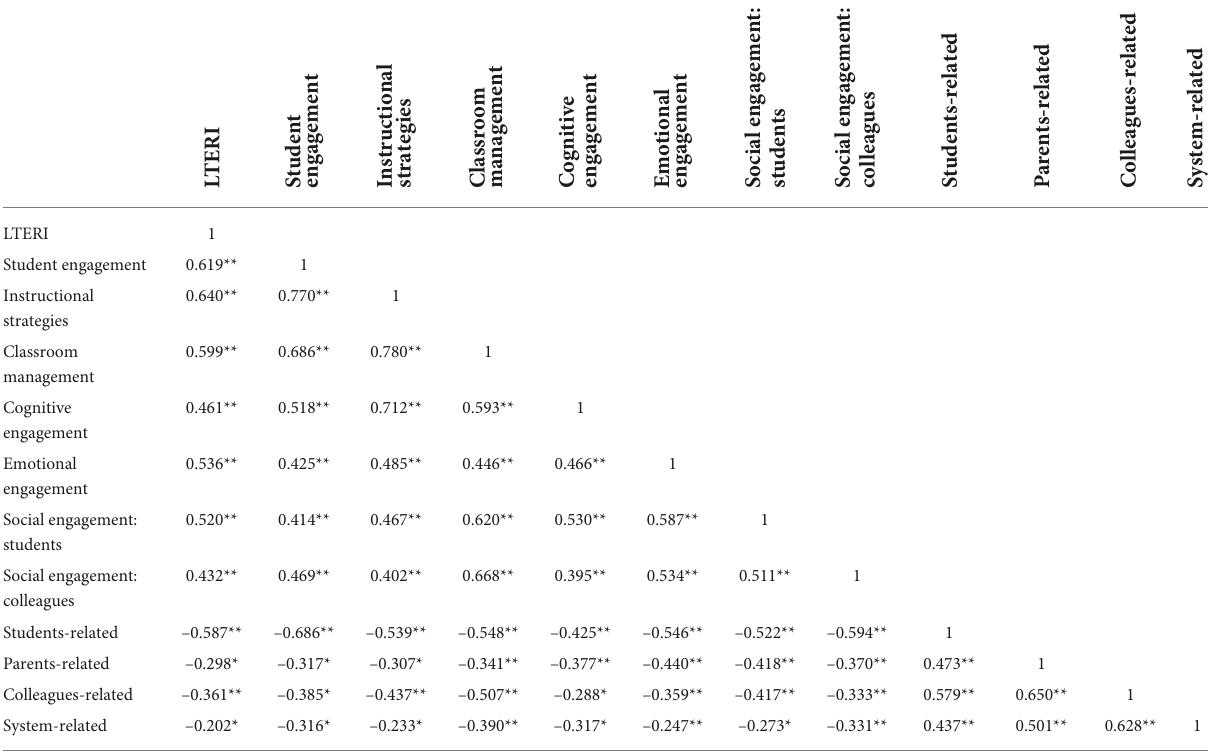
TABLE 5 The correlation coefficients among language teacher emotion regulation and the sub-components of self-efficacy beliefs, engagement, and